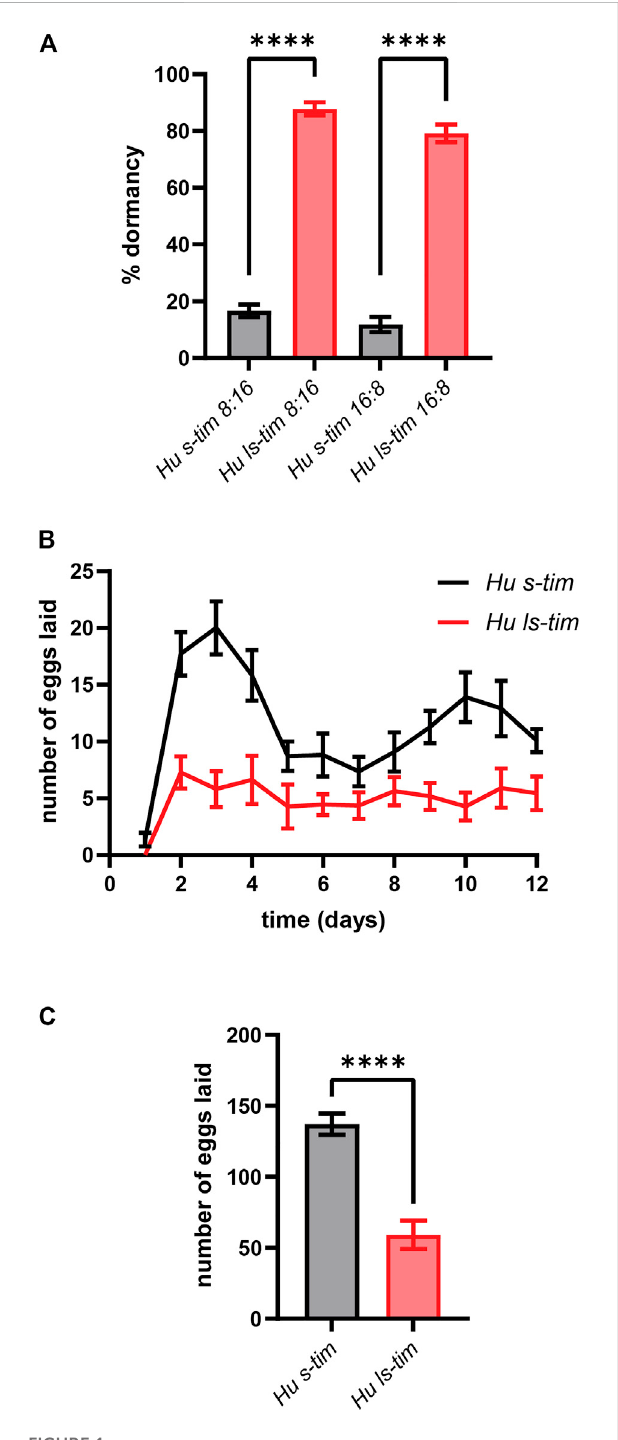
FIGURE 1 ls-tim homozygous females show reduced early-life fecundity compared to their s-tim homozygous counterparts. The lines used in this study are called Houten (Hu) s-tim and ls-tim , from the location in the Netherlands where the natural population of origin was collected. (A) Proportions (±SEM) of s-tim (black) and ls- tim (red) homozygous females in reproductive dormancy after 11 days at 12 ° C under both short (LD 8:16) and long (LD 16:8) photoperiods. Statistical analysis was performed using one- way ANOVA ( post hoc : Tukey test), df = 19, **** p < 0.0001. (B) Average number of eggs laid daily (±SEM) by s-tim and ls-tim homozygous females at 23 ° C (LD 12:12) during the fi rst 12 days of adult life. Statistical analysis was performed using the